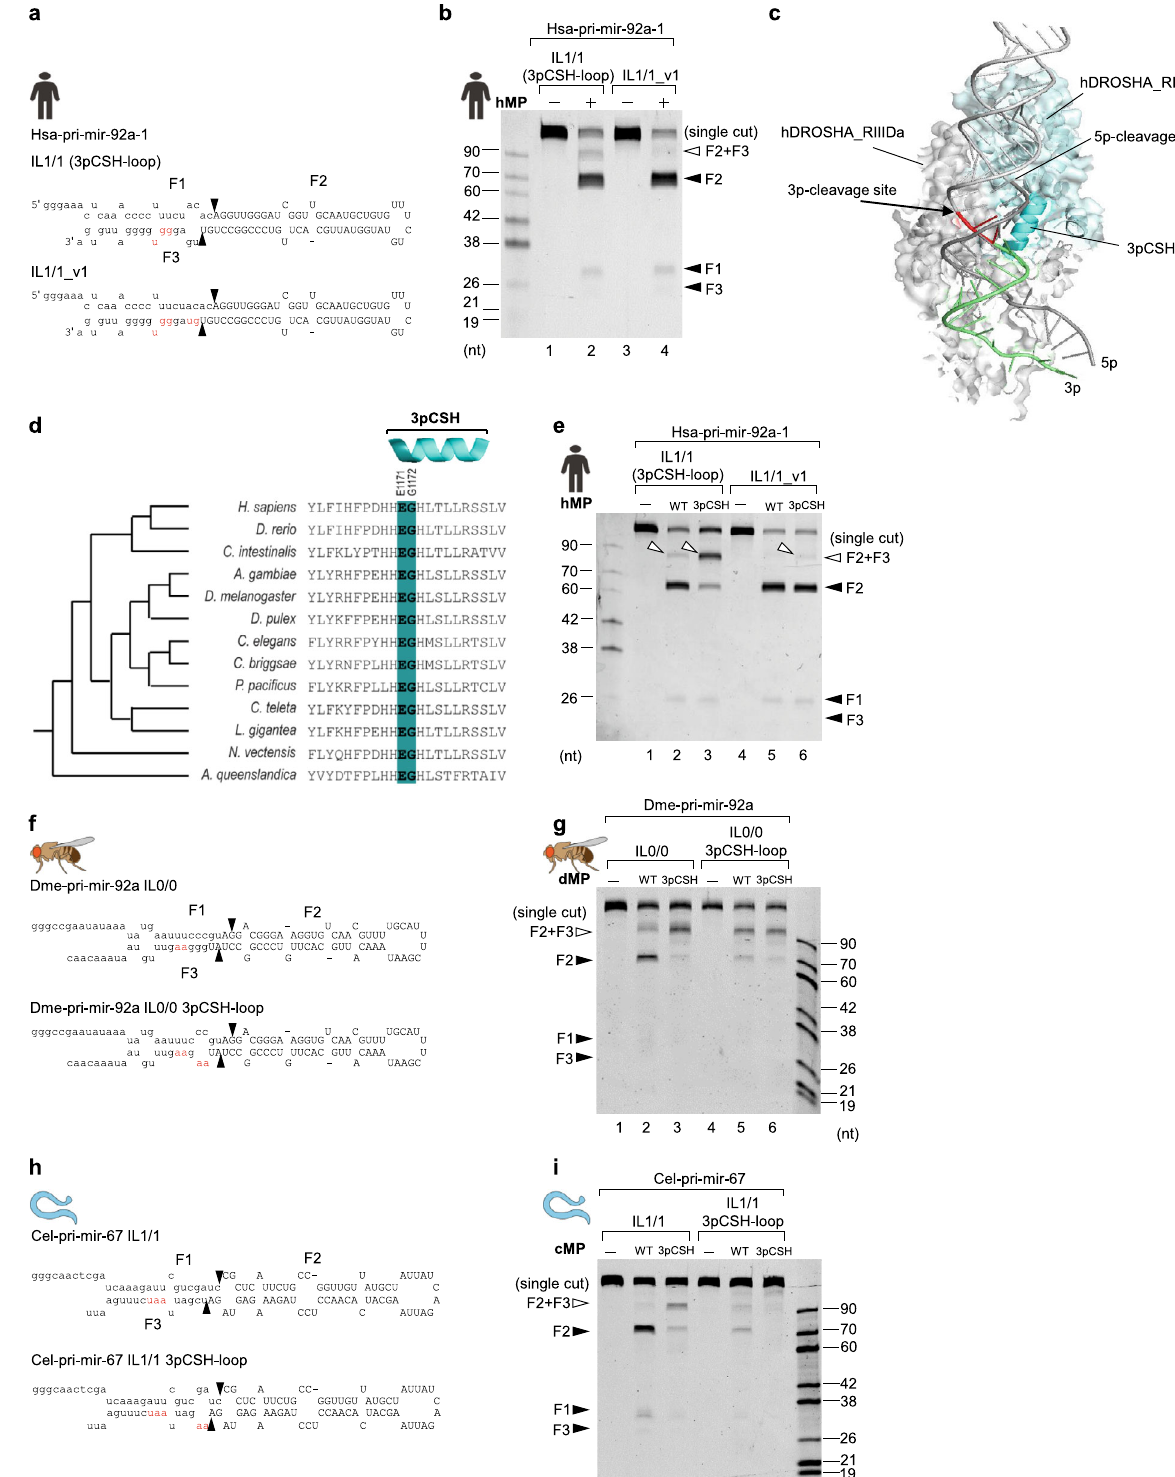
Fig. 6 The conserved functions of 3p-strand cleavage-supporting helix (3pCSH) in ensuring the double cleavage of animal DROSHAs. a , f , h Diagrams and sequences of pri-miRNAs and their variants. The mutated nt are in red. b , e , g , i Pri-miRNA cleavage assays. Five pmol of each pri-miRNA were incubated with 5 pmol of human WT or mutant Microprocessor (in b , e ), or 3 pmol of each pri-miRNAs were incubated with 3 μ L of fl y or worm WT and mutant Microprocessor-bound IgG beads (in g , i ) for 2 h at 37°C. c The DROSHA-RNA interaction model was animated from PDB: 6V5B (a similar model was also obtained from PDB: 6LXD). The 3p-CSH was colored in cyan. The amino acids of the 3p-CSH and the RNA elements, which might make a potential interaction with each other, were shown in deep-teal and red, respectively. The 3p-strand of the lower stem was shown in lime. d The conservation of the 3p-CSH in animals. The polypeptides of the 3pCSH region of DROSHA from 13 organisms were aligned using Clustal Omega 31 .